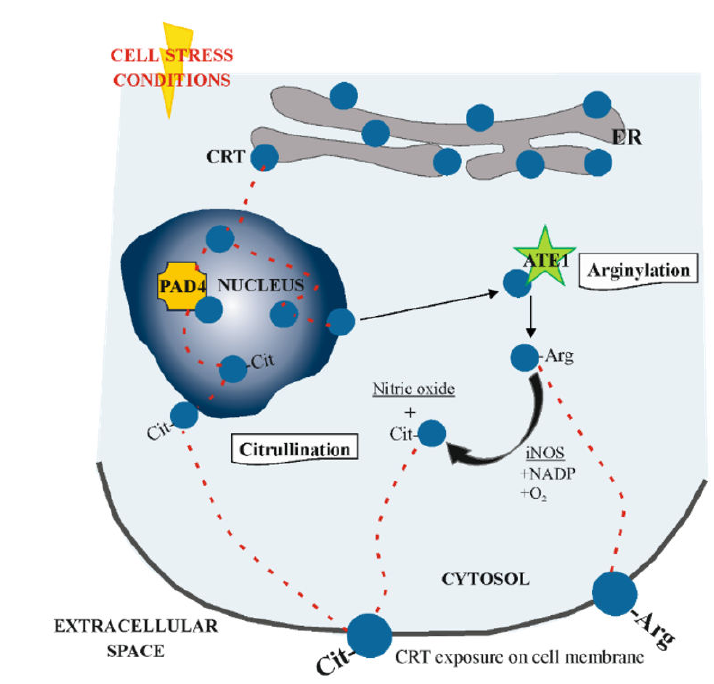
Figure 4. Mechanism of retrotranslocation of calreticulin (CRT) to cytoplasm. Under cell stress condition, CRT leaves the properly functioning ER and translocates to the nucleus. Here, it is exposed to protein arginase deaminase 4 (PAD4) and may be citrullinated (Cit-CRT), or not, before shuttling to the cytoplasm in association with nuclear export proteins. In cytosol CRT interacts with arginyl-tRNA transferase (ATE1), thus being arginylated (CRT-Arg). This isoform can be further citrullinated in the presence of inducible nitric oxide synthase (iNOS), as a byproduct of nitric oxide production from the conversion of arginine to citrulline. Both isoforms of CRT are identified in the plasma membrane of the